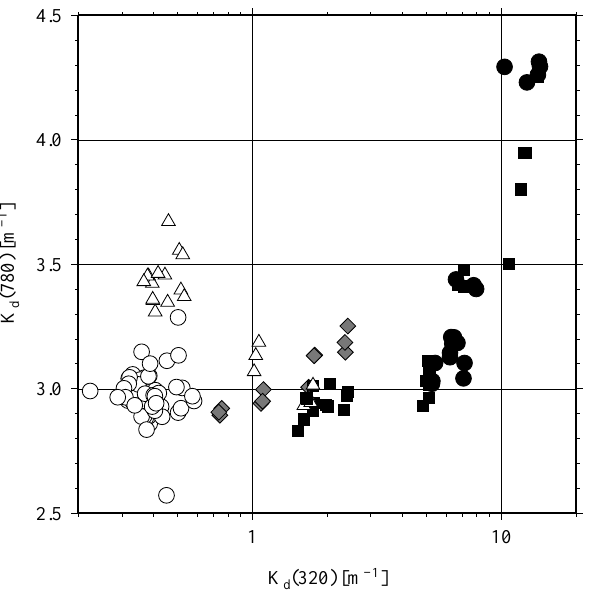
Fig. 4. K d (780) as a function of K d (320). The grouping of points shown here was used to group stations into different clusters as fol- lows: offshore clear-water stations (open circles), coastal stations (gray diamonds), the western Mackenzie transect (black squares), the eastern Mackenzie transect (black circles), and ice-edge stations (open triangles).